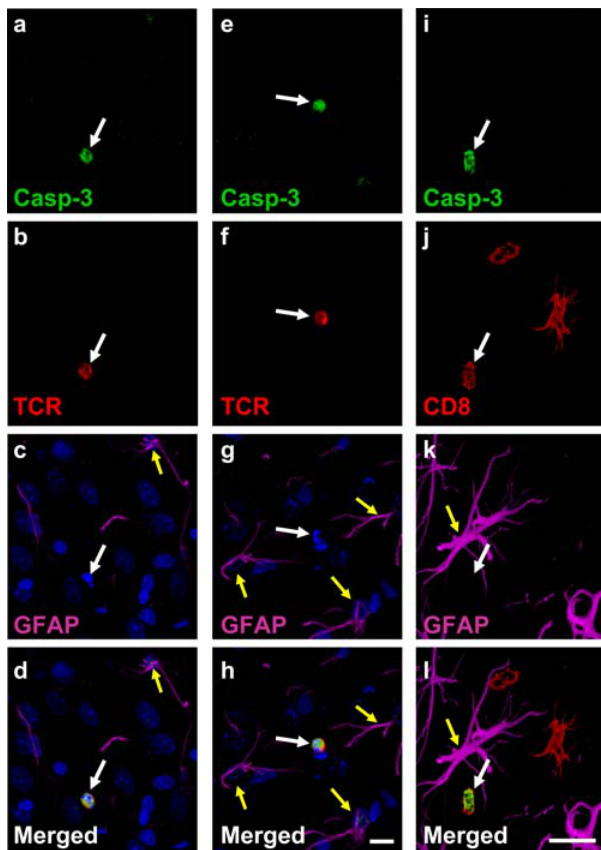
Figure 10. CD8 + T cells, but not infected astrocytes display caspase-3 activation following immunization. Figure 10 illustrates the striatum from rats injected intracerebrally with Ad-TK and systemically immunized against adenovirus, and immunolabeled to detect potential apoptosis of infected cells. Tissue sections were labeled with antibodies that recognize activated caspase-3 (green), the T cell markers TCR or CD8 (red), the astrocyte marker GFAP (magenta), and DAPI (blue). Numerous GFAP-immunolabeled astrocytes (yellow arrows) and TCR + or CD8 + T cells (white arrows) were examined; only T cells showed caspase-3 activation (white arrows). Scale bar (a–h; shown in h)=10 m m; scale bar (i–l; shown in l)=20 m m.